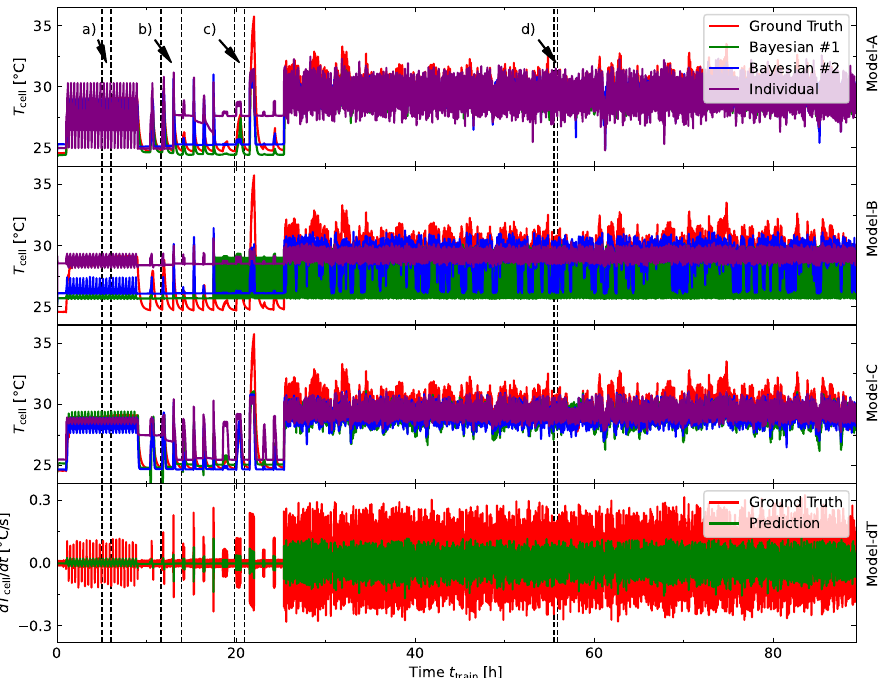
Figure 9. Predicted values of all models in four subfigures are given for the training data set. Model-A to Model-C show ground truth, Bayesian #1, Bayesian #2 and the most promising individual results. Model-dT illustrates ground truth and the predicted values of the dT-Model. Four areas are marked from ( a – d ).